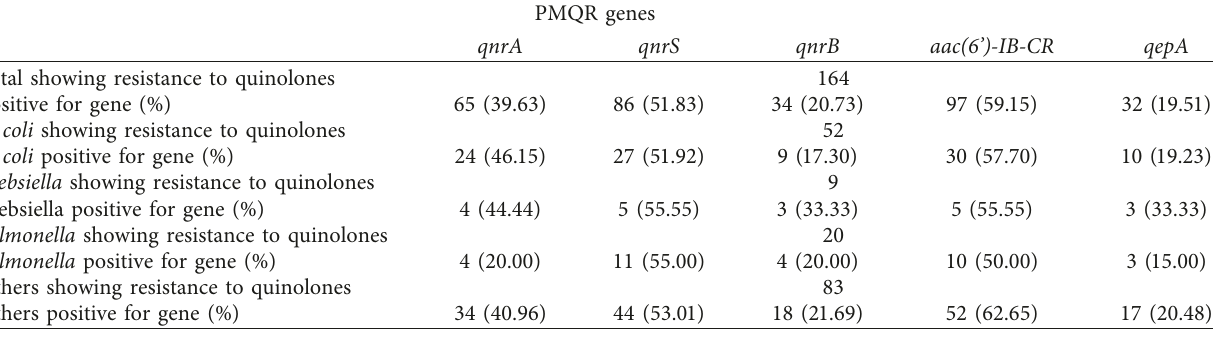
Figure 7: Gel image showing the amplification of the blaTEM-1 gene fragment at 500bp. Table 10: Prevalence of PMQR genes detected by PCR.